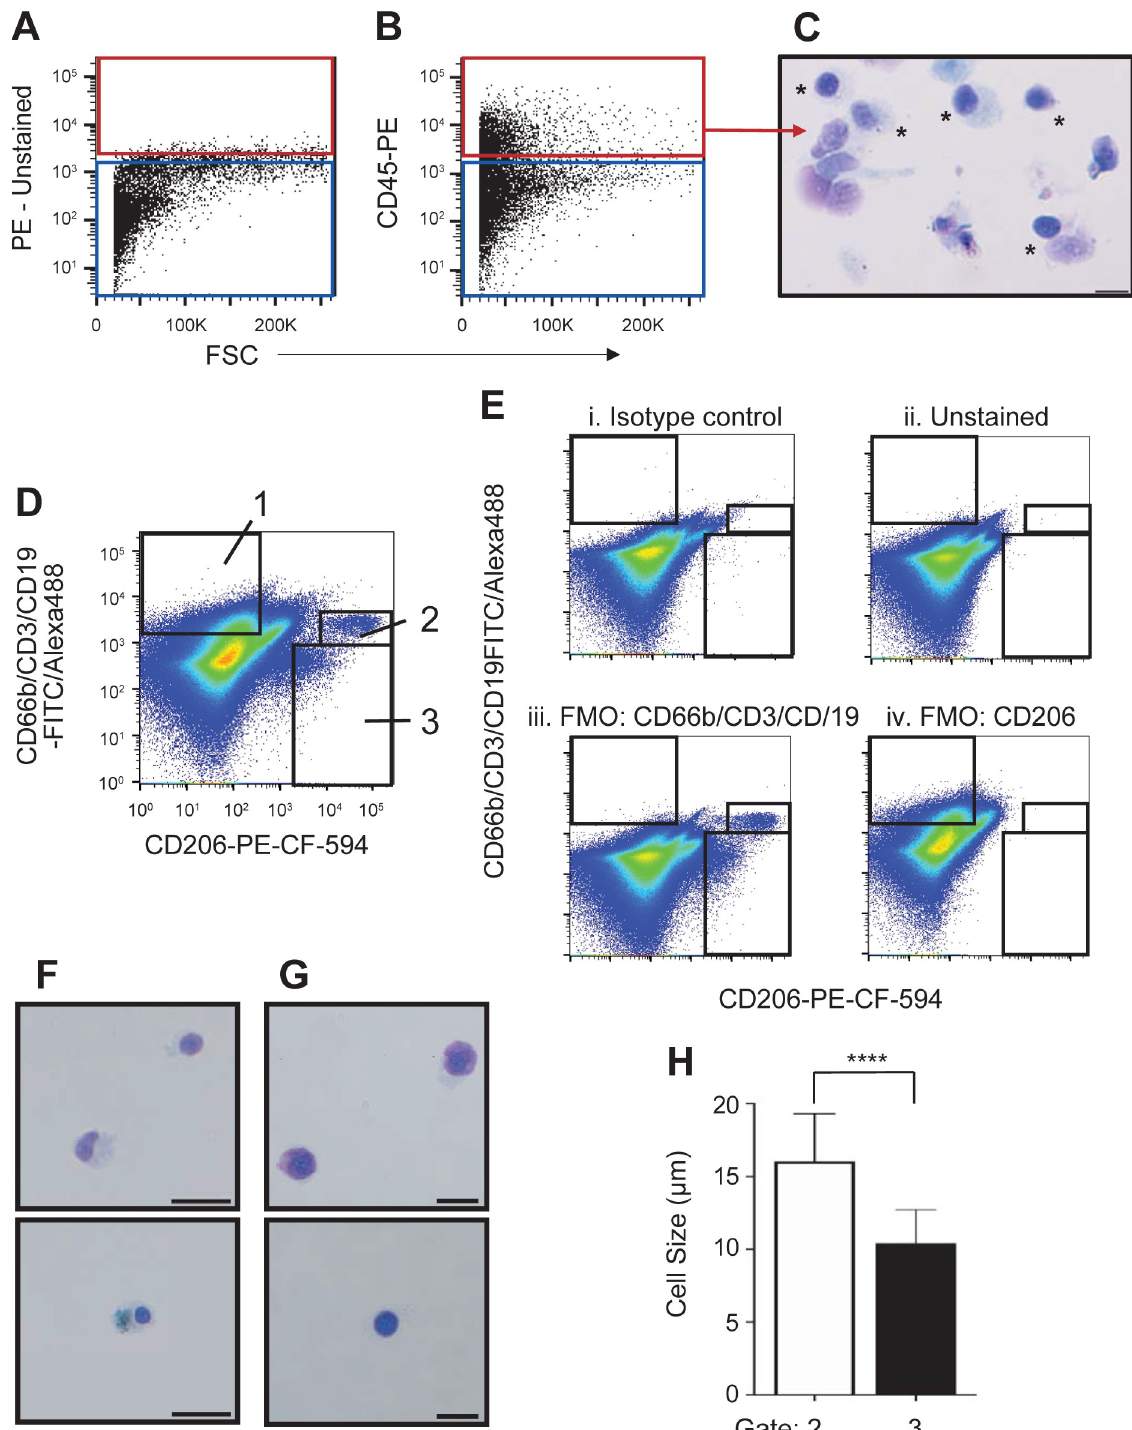
Fig 3. Sputum-derived leukocytes include distinct sub-populations of macrophages. A-E) Presented are cells selected through a size exclusion gate and a live cell gate as shown in Fig 1, as well as a doublet discrimination gate (not shown). A ) Representative light scatter profile of unstained single, live sputum cells defining both the CD45 + (red) and CD45 - gates (blue) for sorting and further analysis. B ) Live, single sputum cells stained with the blood panel of antibodies. The red box defines the CD45 + sorting population. C ) Wright-Giemsa-stained cells obtained by sorting the CD45 + population, showing various types of leukocytes ( � ). D ) Sputum-derived leukocyte profile of FVS510 - CD45 + cells from a different sample stained with the antibodies indicated on the x- and y -axes. The black boxes indicate the gates used to identify